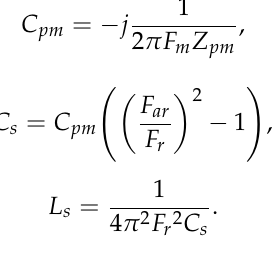
Figure 7. QCM based on Virtual Impedance Analyzer.